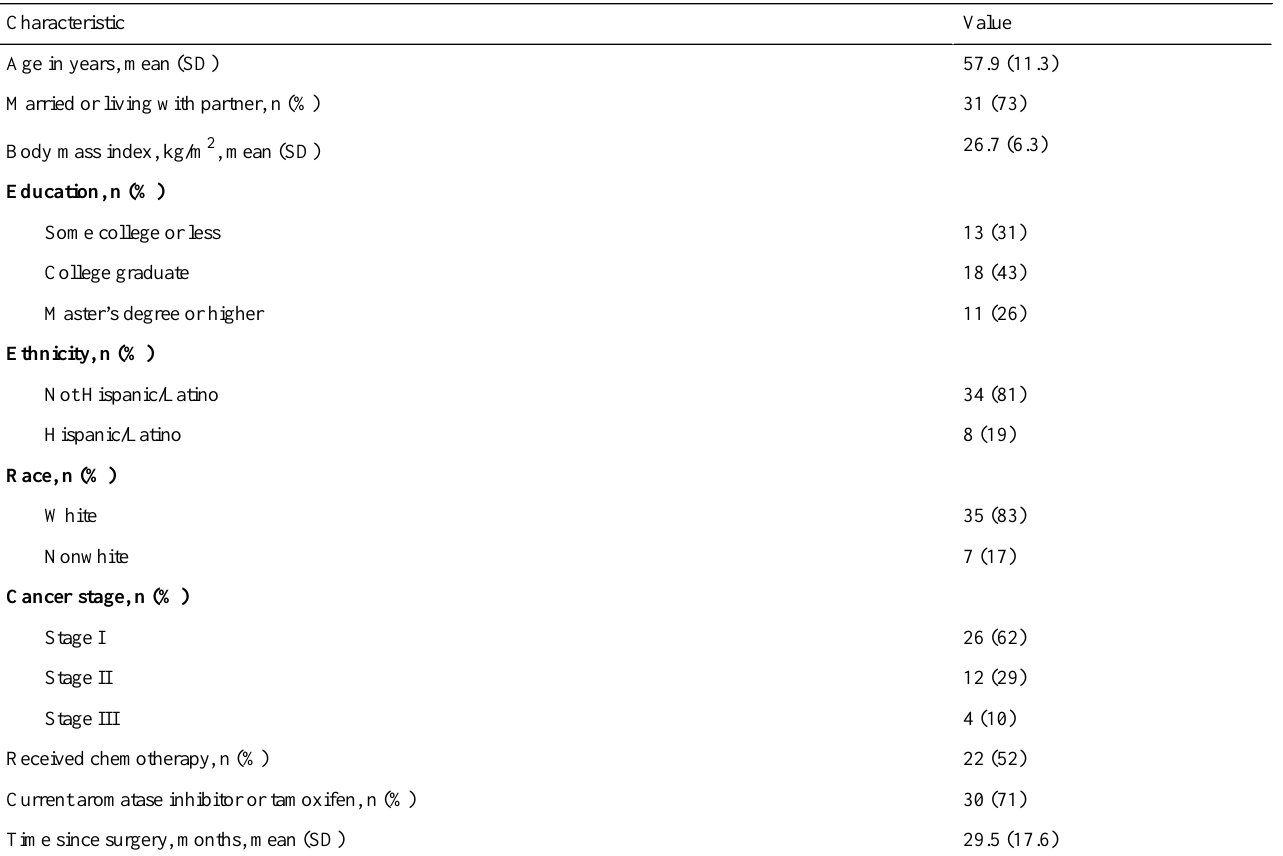
Table 1. Baseline characteristics (N=42).